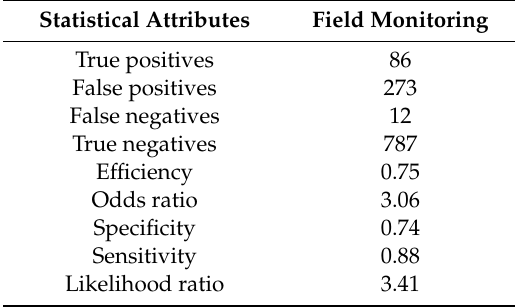
Table 3. Prediction performance of field monitoring data.